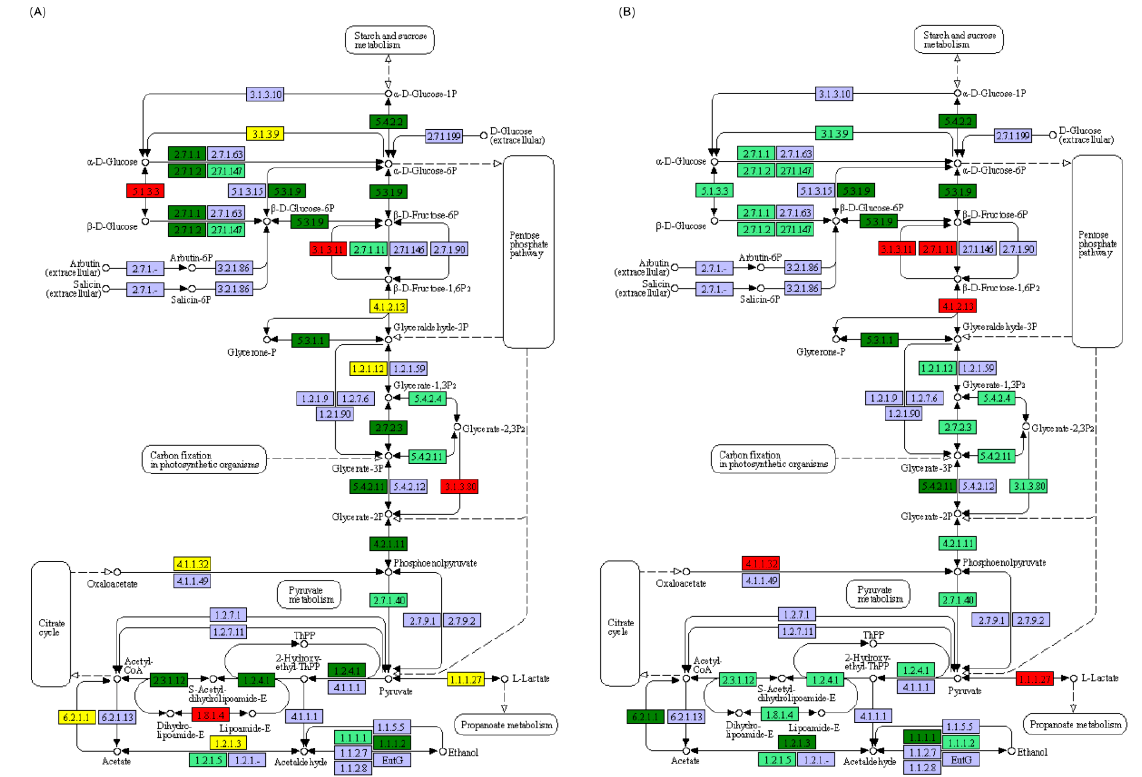
Figure 6. Kyoto Encyclopedia of Genes and Genomes pathway showing the significantly upregulated and downregulated genes involved in glycolysis/gluconeogenesis in the liver transcriptome of yellowcheek starved for ( A ) 8 and ( B ) 28 d compared to the control groups at the same time. Red, dark green, yellow, light green, and light purple indicate significantly upregulated genes, downregulated genes, and both upregulated and downregulated genes in the corresponding genes, the genes of the species annotated on the map, and the genes that were not annotated on the map,